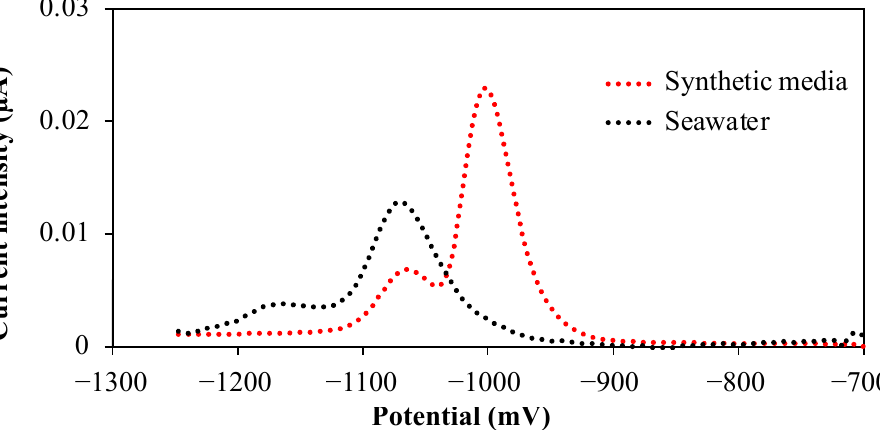
Figure 4. Simultaneous detection of Co(II) and Ni(II) in both synthetic media (red dotted line) and seawater (black dotted line). The added nickel concentrations were 12 nM in the synthetic media and 6 nM in UV-SW, while the Co(II) ones were, respectively, 8 and 2 nM in the synthetic media and in seawater.